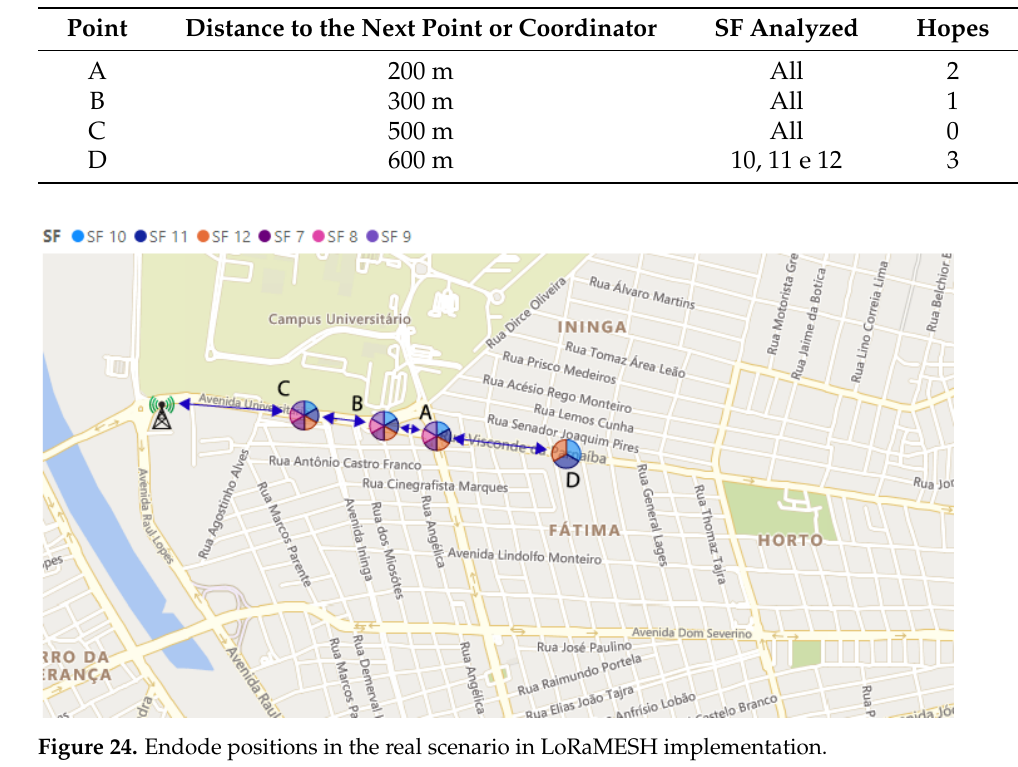
Table 4. LoRaMESH Real Scenario Point Specifications.